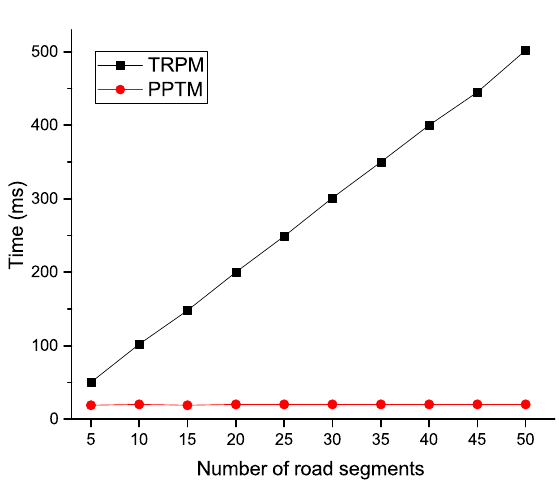
Figure 8. Computational costs of average speed calculation at the SP